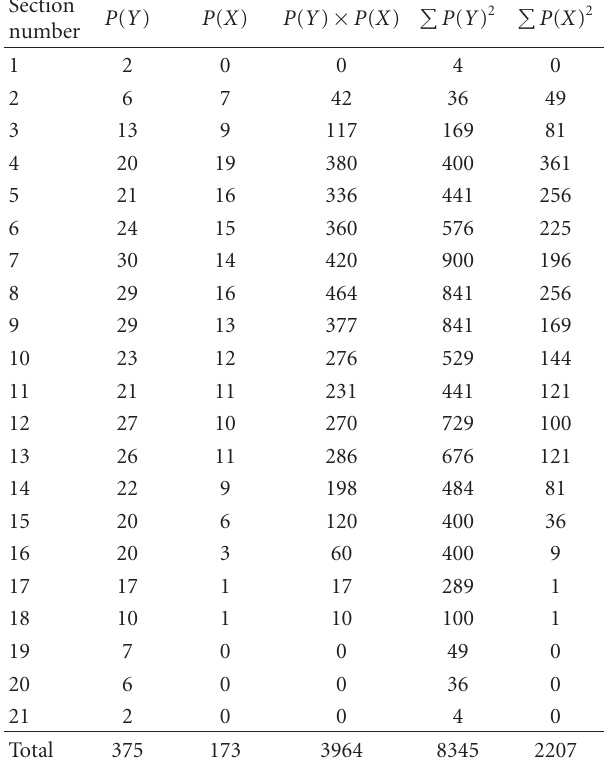
Table 1: An example of the application of volume and the volume fraction method described in the present study. P ( Y ) = number of points hitting the cross section of the cerebellum. P ( X ) = number of points hitting the cross section of the herniated